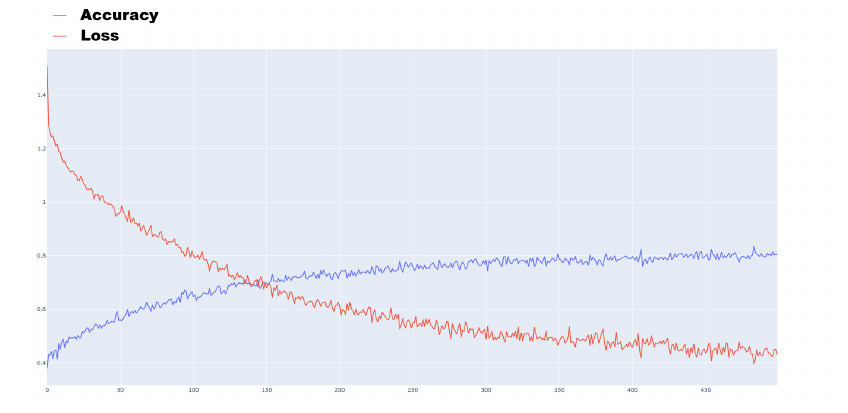
Figure 3. Classification neural network training results.